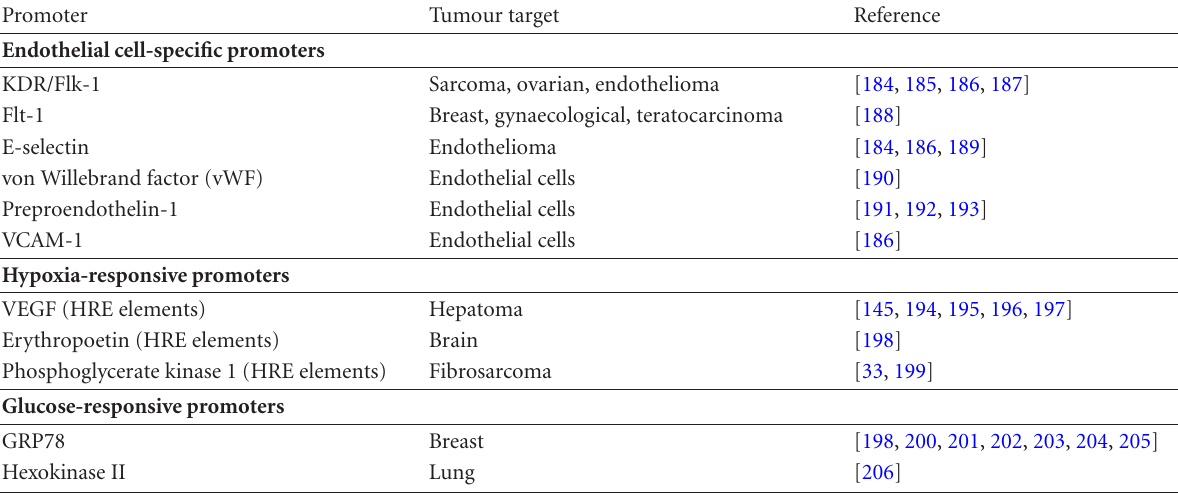
Table 3. Tumour environment-specific